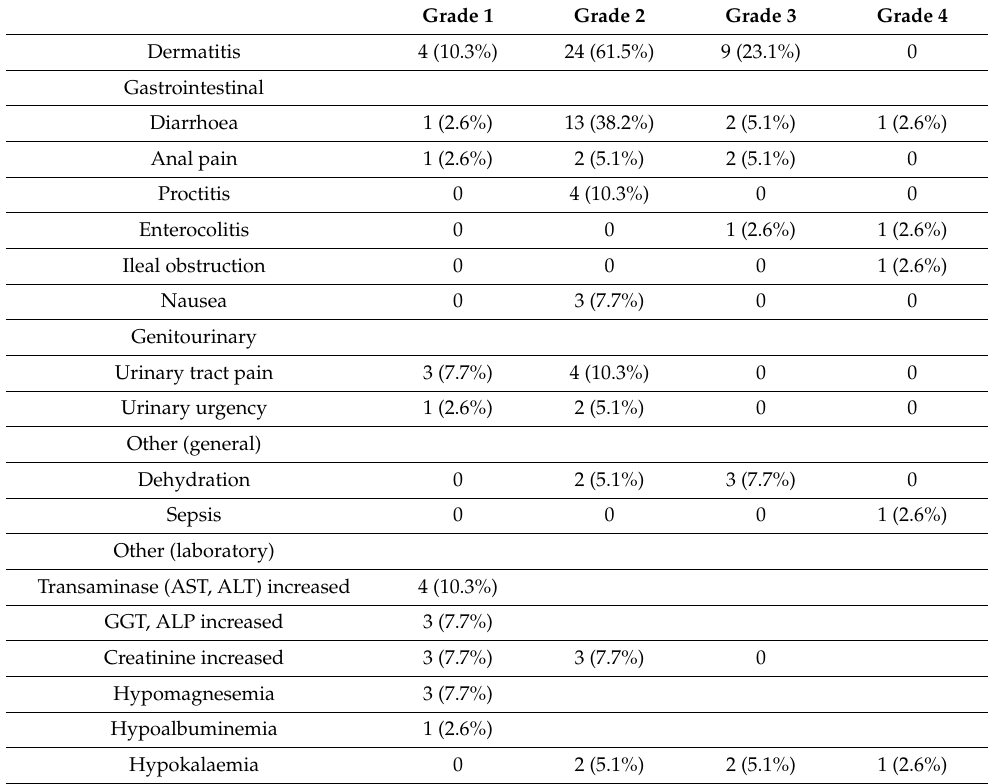
Table 4. Acute non-haematologic toxicity (CTCAE version 4.0).